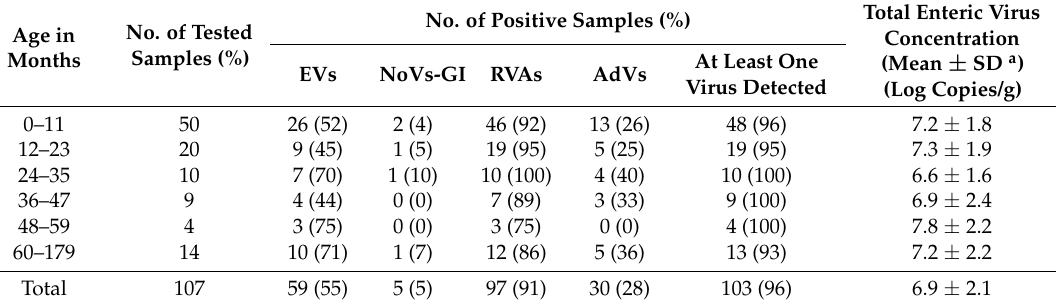
Table 1. Detection of enteric viruses in stool samples.